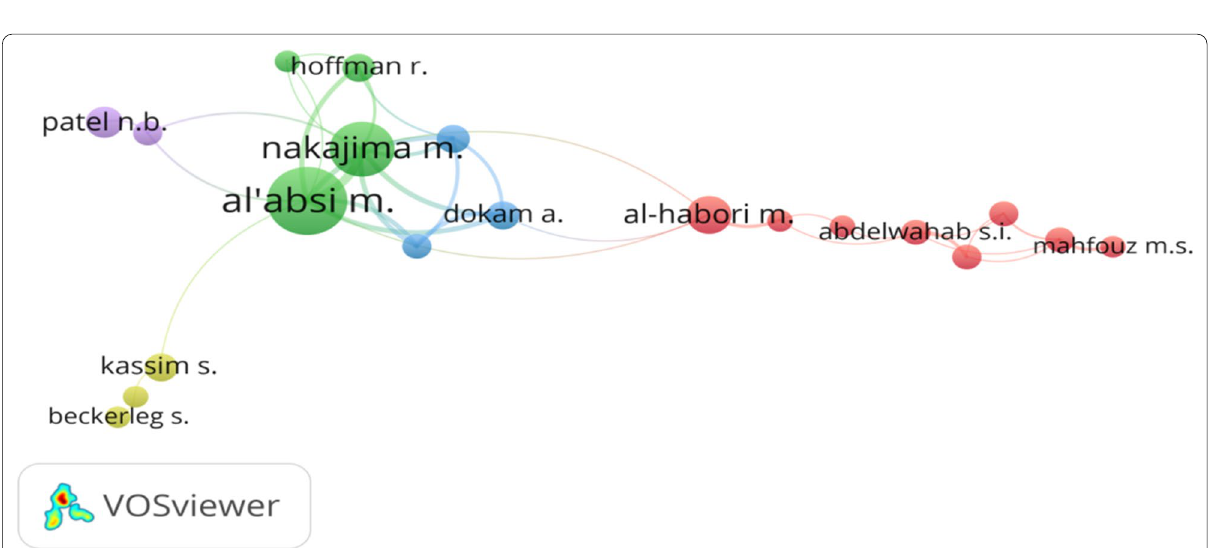
Fig. 8 Networks of co-authorship have five or more documents. Only authors with five or more documents were mapped ( n